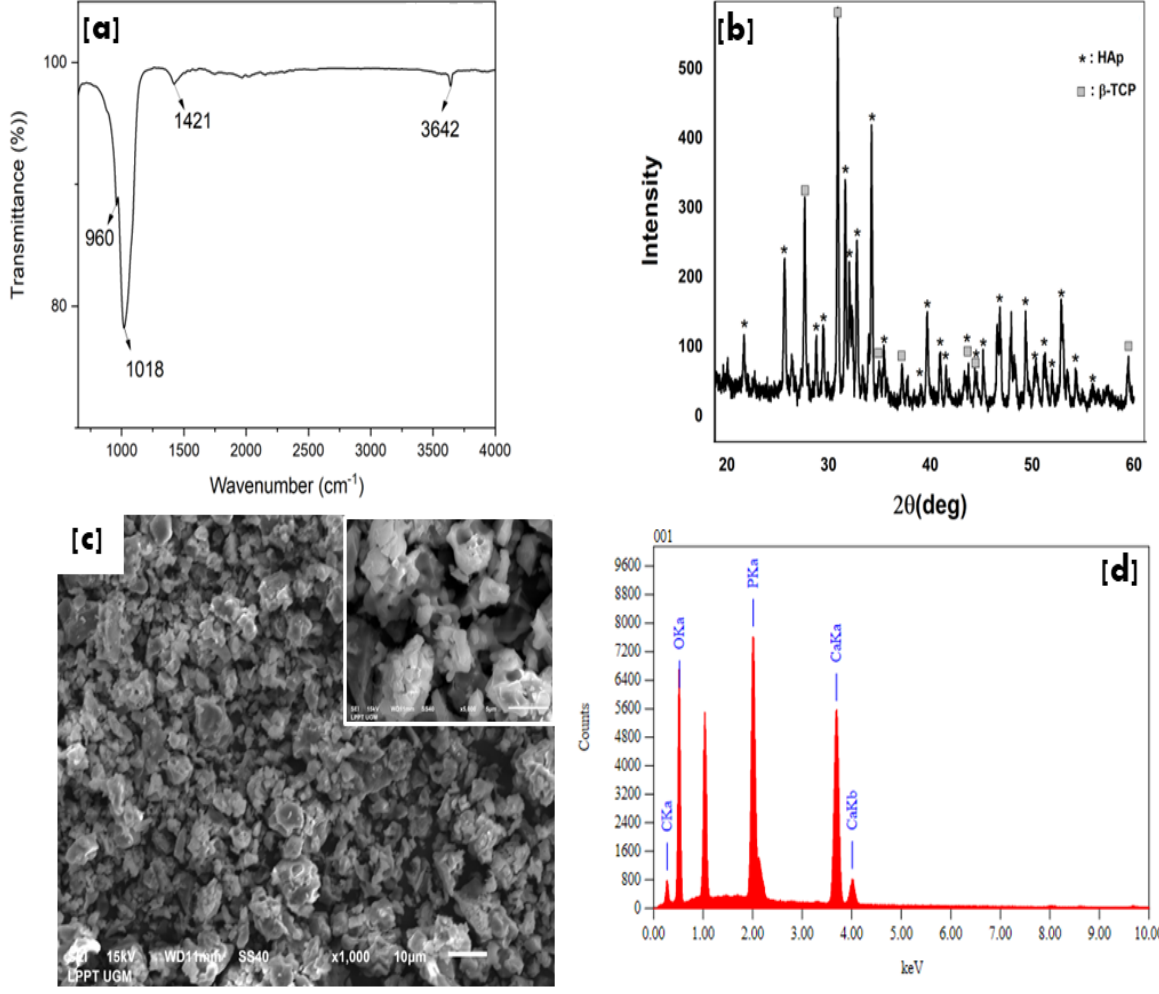
Figure 2. HAp Characteristics of FTIR ( a ), XRD ( b ), SEM morphology with a magnification ×1000 (inset ×5000) ( c ), and EDS spectra ( d ).